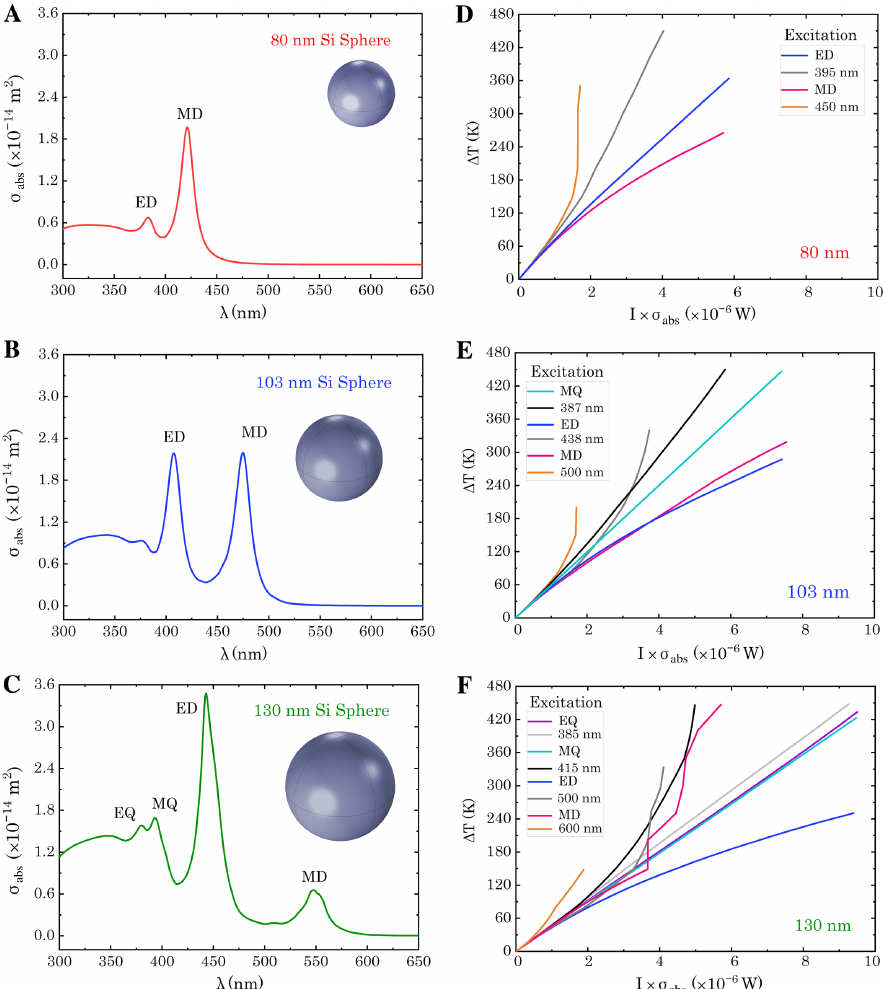
Figure 3: Analytical analysis of self-induced heating of Si nanospheres. (A–C) Absorption cross section at room temperature of three Si spheres with diameters of 80-, 103-, and 130-nm Si sphere; (D–F) temperature increase observed upon illumination at the indicated on- or off-resonance wavelengths as a function of the effective absorbed power. Self-limiting, linear, divergent, and fluctuating behaviors are observed, illustrating the complexity of self-induced optical